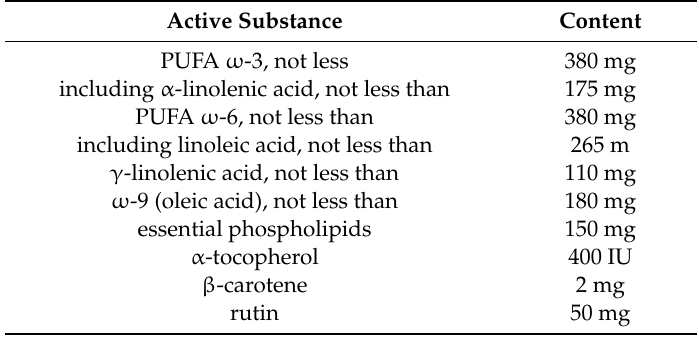
Table 1. Active substances in the “ESB-1” dietary supplement (per one 2.0 g capsule). Active Substance Content PUFA ω -3, not less 380 mg including α -linolenic acid, not less than 175 mg PUFA ω -6, not less than 380 mg including linoleic acid, not less than 265 m γ -linolenic acid, not less than 110 mg ω -9 (oleic acid), not less than 180 mg essential phospholipids 150 mg α -tocopherol 400 IU β -carotene 2 mg rutin 50